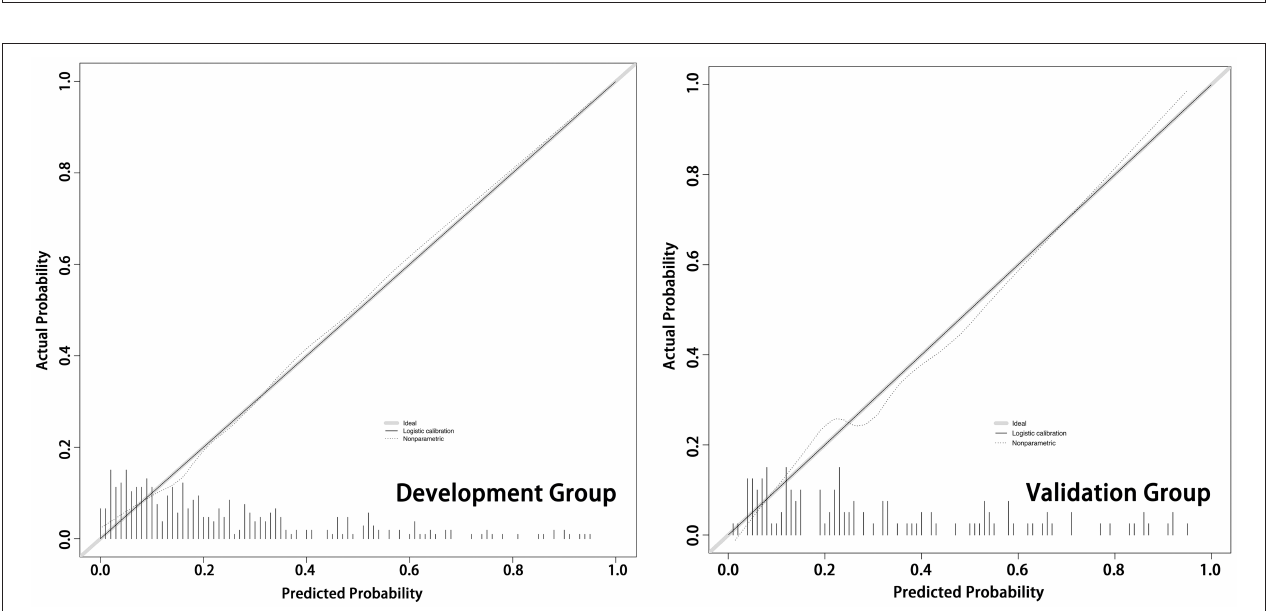
FIGURE 4 | The ROC curves of the development cohort and validation cohort.